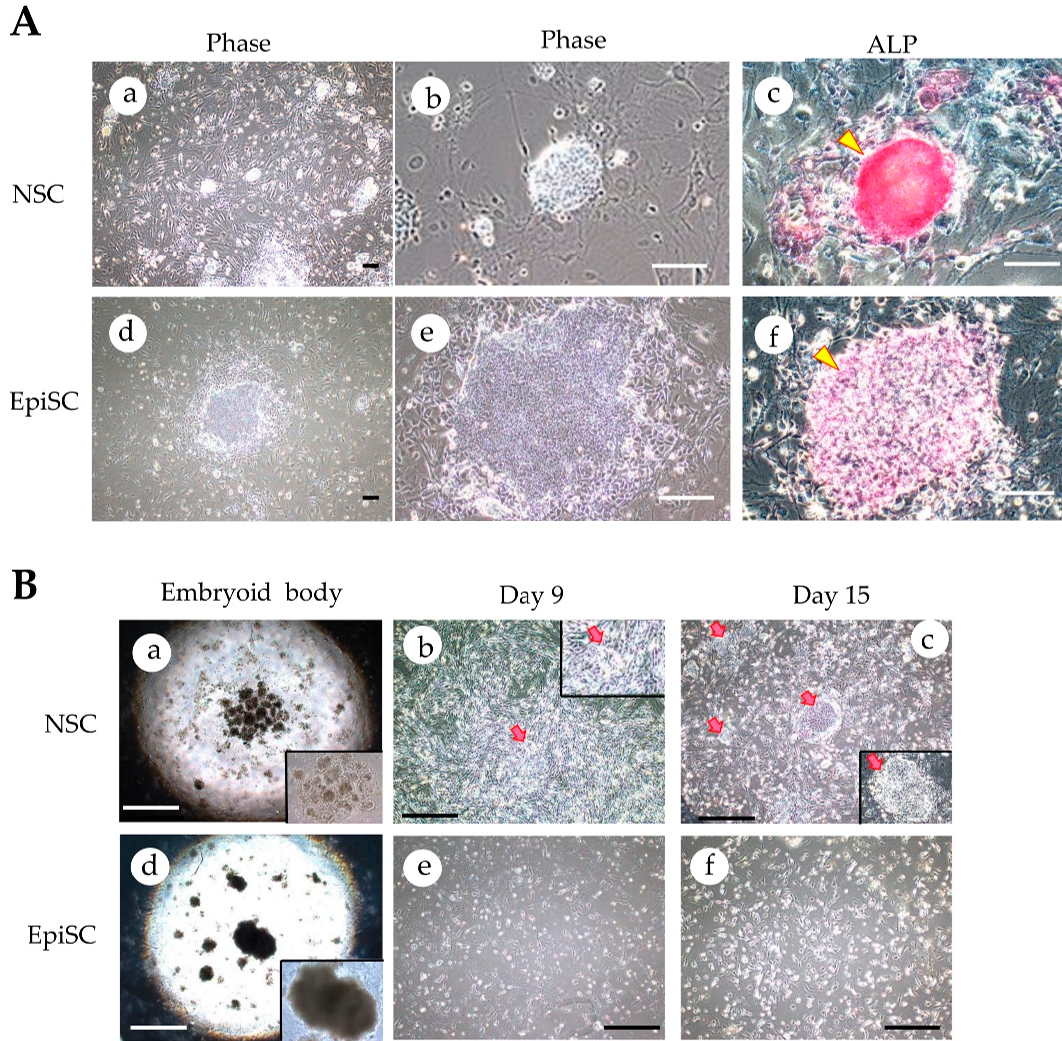
Figure 2. Microscopic observation of naïve stem cells (NSCs), epiblast stem cells (EpiSCs), and their differentiation derivatives. ( A ): Morphology of (a, b, d, e) and alkaline phosphatase (ALP) activity in (c,f) NSCs and EpiSCs. Photographs were taken 5 days after seeding the cells onto mouse embryonic fibroblastic (MEF) cells as feeder cells. ALP activity was measured using a cytochemical staining kit for ALP activity after fixation of cells. Arrowheads indicate the ALP active cells. Bar = 10 µm. ( B ): Morphology of NSCs-derived cells (a–c) or EpiSCs-derived cells (d–f). After embryoid body formation (a,d), the cells were subjected to induction of differentiation into pancreatic β -cells. NSC-derived cells at 9 (b) or 15 (c) days after induction are shown. EpiSCs-derived cells at 9 (e) or 15 (f) days after induction are shown. Arrows indicate putative cobblestone-like morphology of induced tissue-specific stem cells for pancreatic cells (iTS-P). In the right bottom of (a,d), enlarged figures of embryoid bodies are shown. In the right bottom of (c), enlarged figures of iTS-P is shown. Bar = 10 µm.